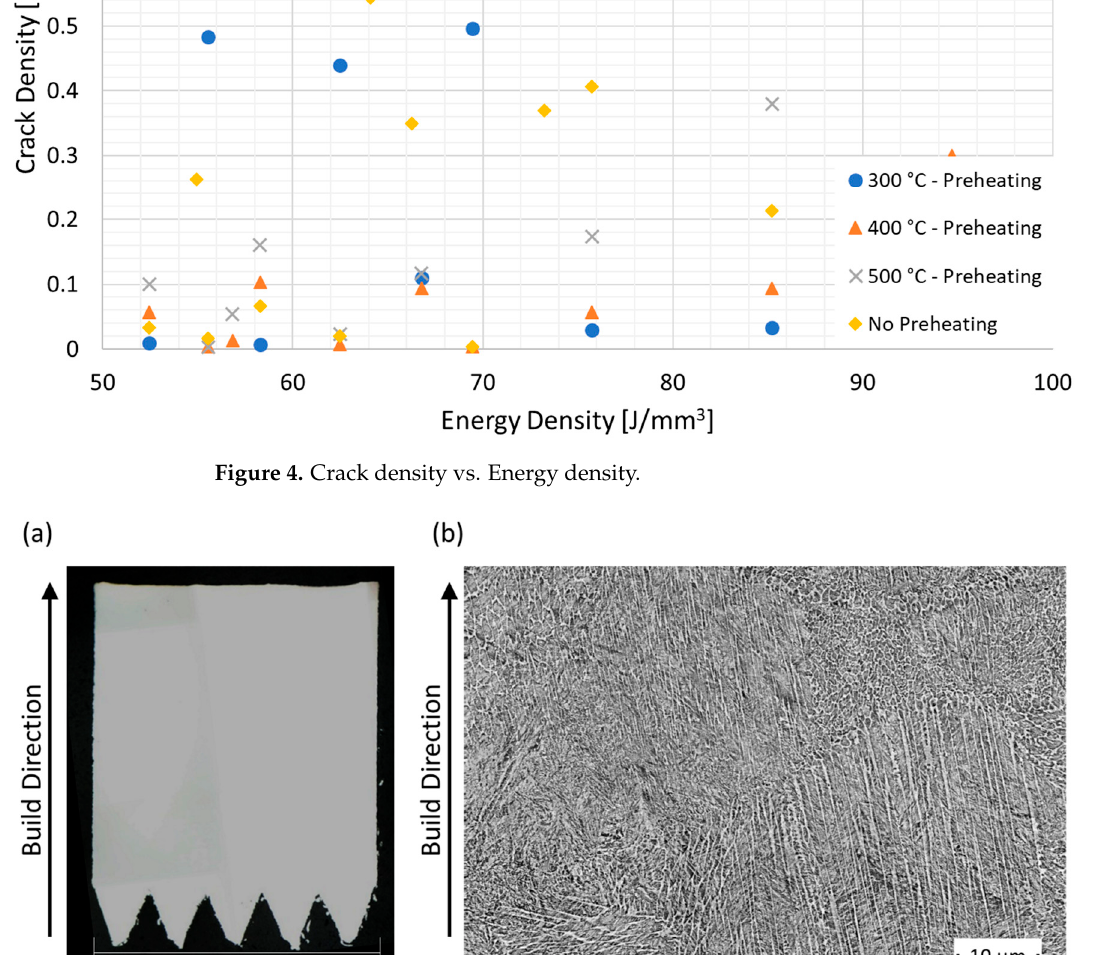
Figure 5. ( a ) Cross-section of sample manufactured without preheating and 69.93 J/mm 3 with 99.99% relative density and no cracks; ( b ) Microstructure of sample shown in ( a ).